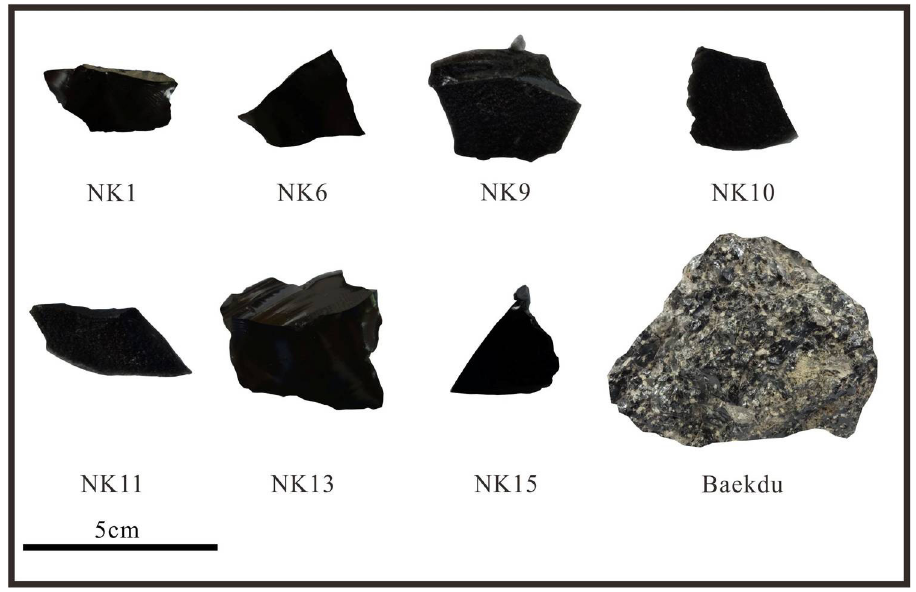
Figure 3. The Baekdusan obsidians used in this study. Seven NK obsidians were collected from a massive obsidian mine located at the southern flank of Mt. Baekdusan, and one sample, Baekdu, was from a trachytic lava layer.